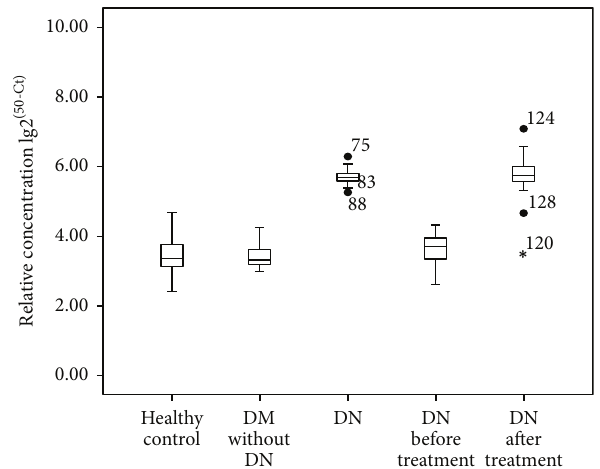
Figure 2: Urinary miR-126 levels of different crowds. Urinary miR- 126 level in DN patients was higher than DM without DN patients and healthy controls, 𝑃 = 0.002 . However, there was no significant difference between the healthy control and DM without DN, 𝑃 = 0.324 . After a period of treatment, urinary miR-126 levels in DN patients were